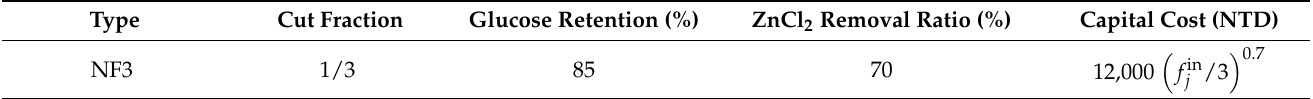
Table 4. Membrane performance and cost data for case 2.